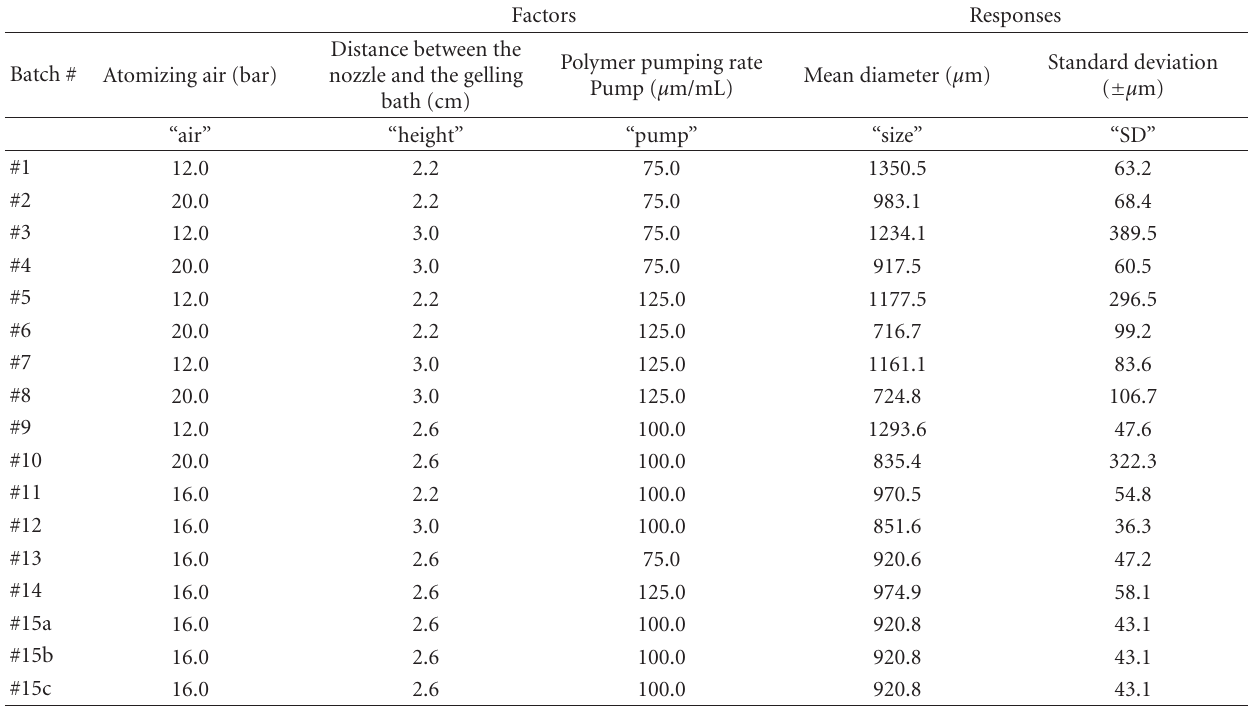
Table 1: Experimental design matrix and results of the DoE (design of experiments) approach for alginate microbeads.